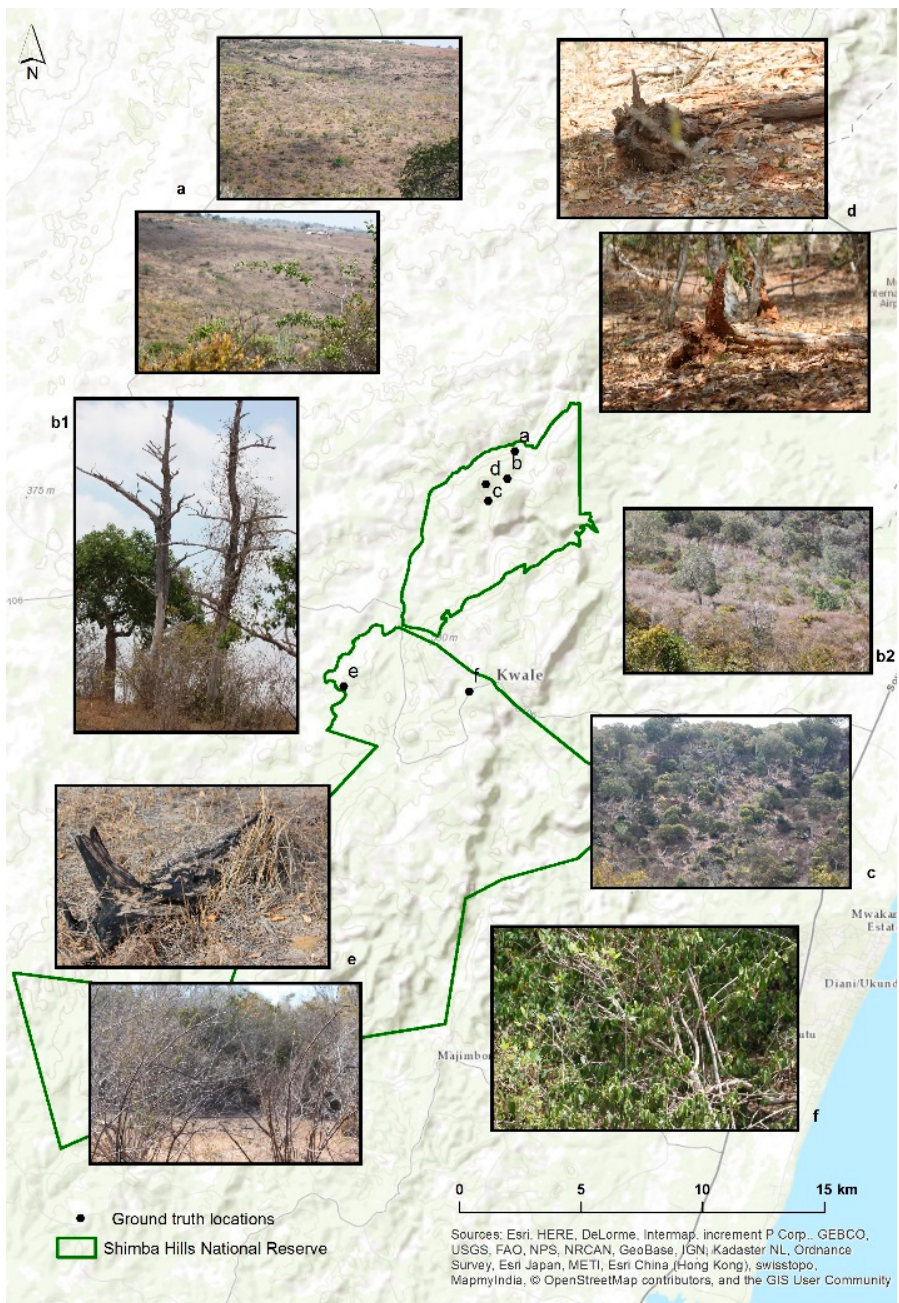
Figure 8. Photos taken during ground truth data collection in 2017 of Shimba Hills National Reserve showing ( a ) Previous areas of forest that have now been opened up ( b1 ) Evidence of bark stripping by elephants ( b2 ) Evidence of regrowth ( c ) Trees trampled by elephants ( d ) Uprooting of trees by elephants ( e ) Areas of fire damage ( f ) Regrowth of shrub in previous areas of forest. The application of BFAST on the TAMSAT data found no statistically significant breaks in the rainfall anomalies throughout the study period. Figure 9 provides a visualization of the temporal profiles of EVI from MODIS, rainfall anomalies and monthly rainfall from TAMSAT. Small changes in the EVI values in 2004 and from 2006 to 2008 may be a response to the climatic driver of the amount of rainfall. The negative rainfall anomalies observed in 2004 might explain the large amount of the